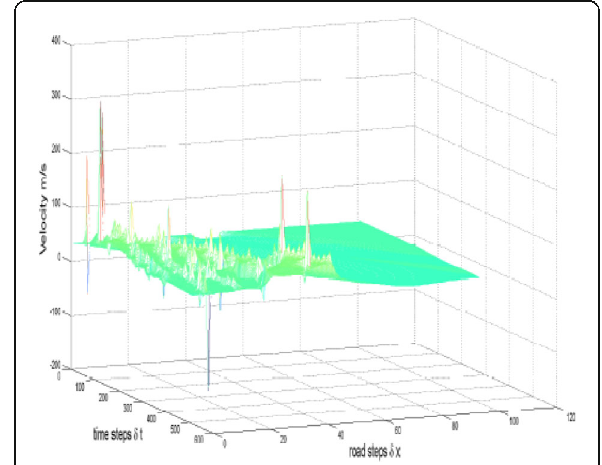
Fig. 8 The proposed model flow with b = 1